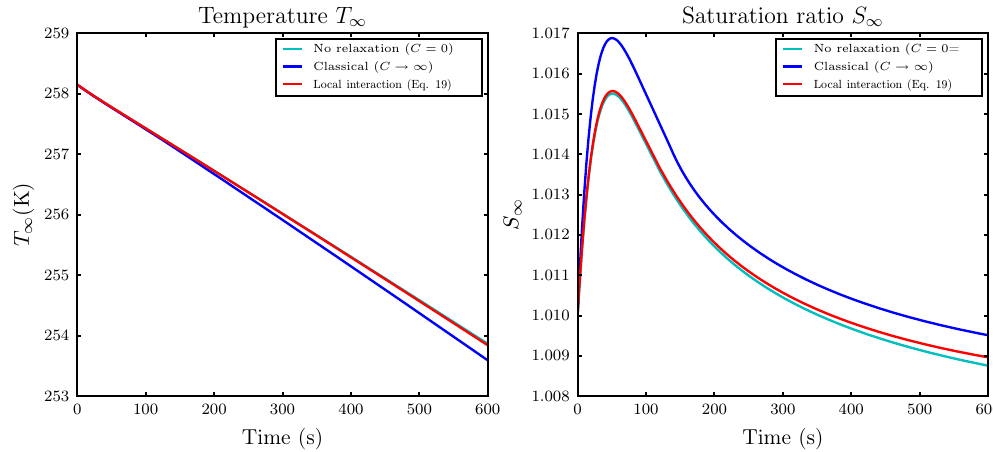
Figure 11. Temporal evolution of air parcel temperature T ∞ and saturation ratio S ∞ with respect to water for the same simulation as in the lower row in Fig. 9 with droplet distance l 0 = 5 R i . Table 2. Summary of the observed effects within the conducted air parcel simulations. Stationary Updraft Downdraft Parameter N d Increasing droplet number per ice influence sphere leads to more pronounced effects. Decreasing ice–droplet distance leads to more pronounced effects. Mostly no effect, but Delay in the evapora- saturated environment. compare the case tion; most pronounced shown in the upper row for initial saturation ra- of Fig. 9. Effects visible; air par- Not cel is warmer compared to the classical case. the classical case.